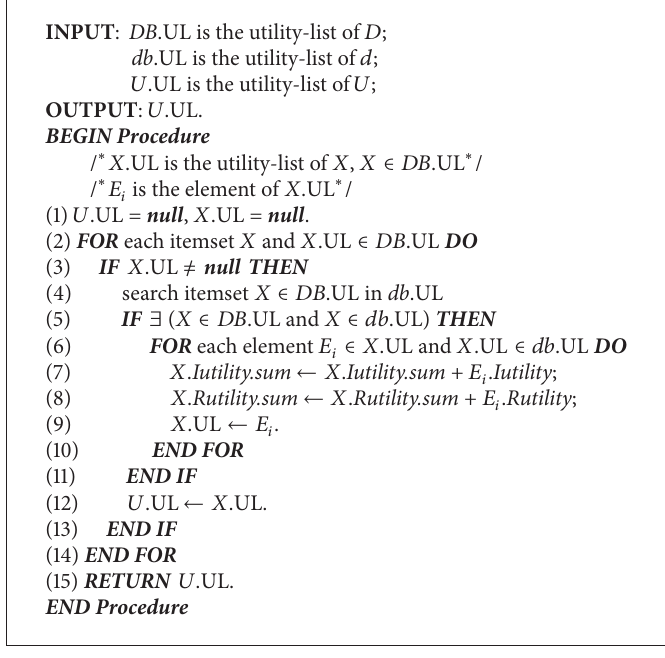
Algorithm 3: Pseudocode of merge-list function.